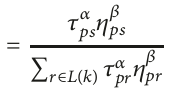
algorithm to solve the SAA problems. ACO is a heuristic algorithm for solving combinatorial optimisation